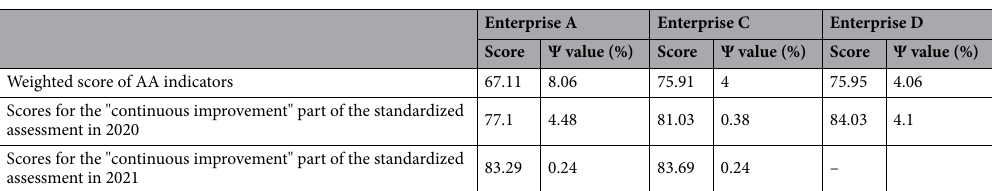
Table 11. Results of the continuous improvement component of the standardized management system compared to the weighted AA8 indicator